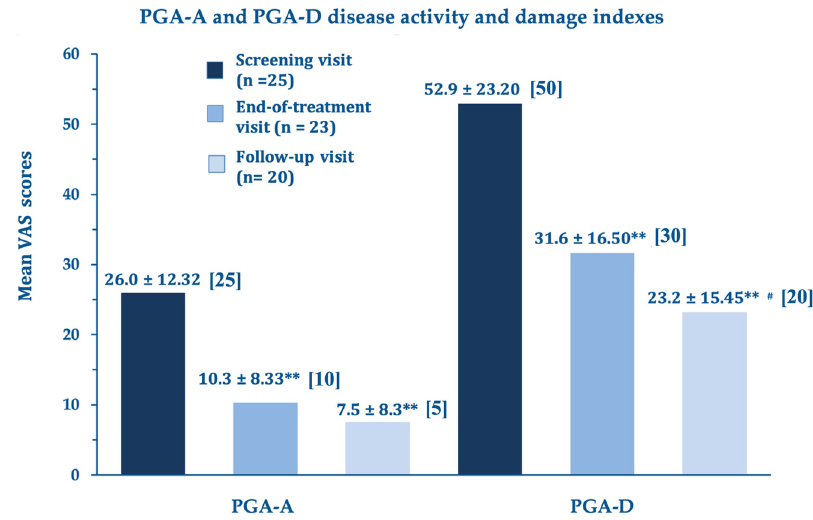
Figure 2. Physician Global Assessment (PGA) subscore analysis: PGA-A and PGA-D mean changes (disease activity and damage, respectively) ± standard deviation and medians, end-of-treatment visit (day 90) and follow-up visit (day 180) vs. screening visit (baseline). ** p < 0.0001 vs. baseline screening visit, # p = 0.023 vs. day 90.